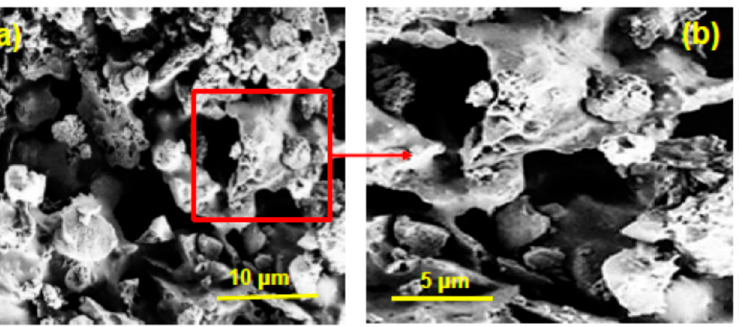
Figure 15. The SEM images for 3#CaO-Zn/13XZ nanocatalyst after the five cycles of pyrolysis: ( a ) Mag = 20.00 KX; ( b ) Mag = 50.00 KX.